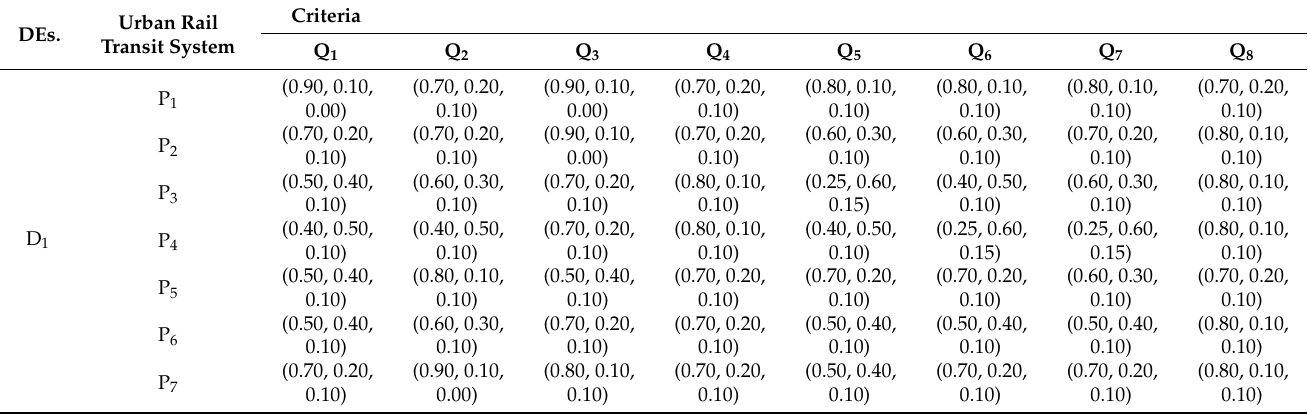
Table 7. The fuzzy decision-making